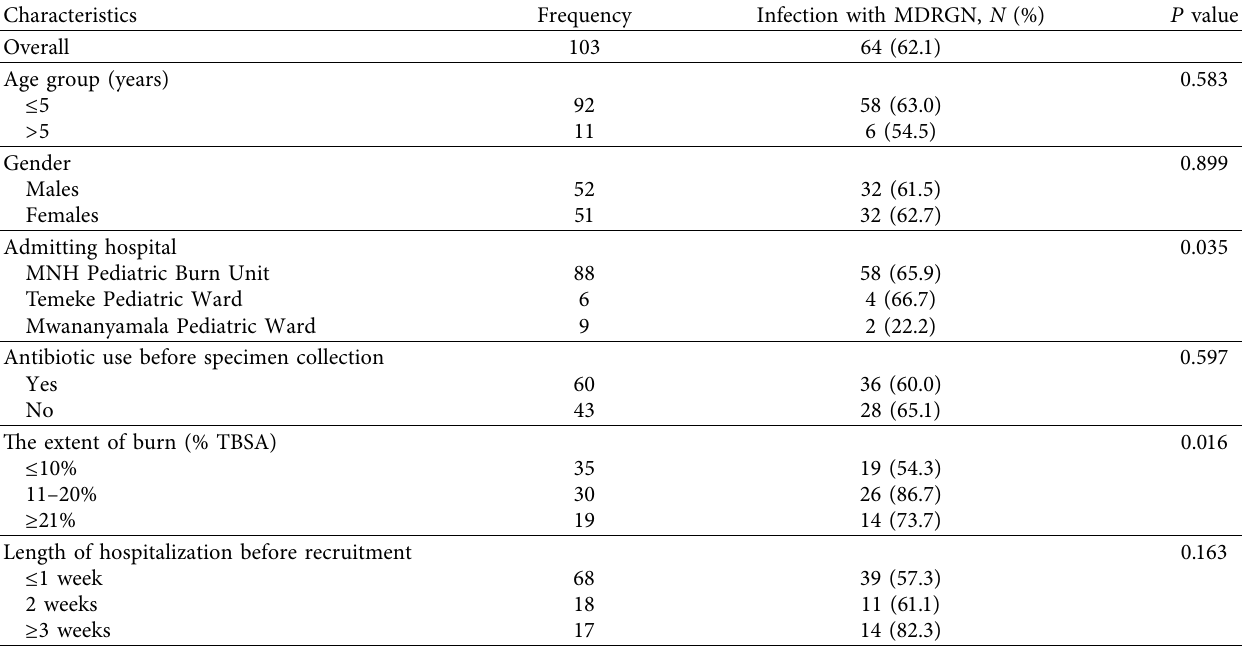
Table 4: Proportion of multidrug resistance and patient characteristics.